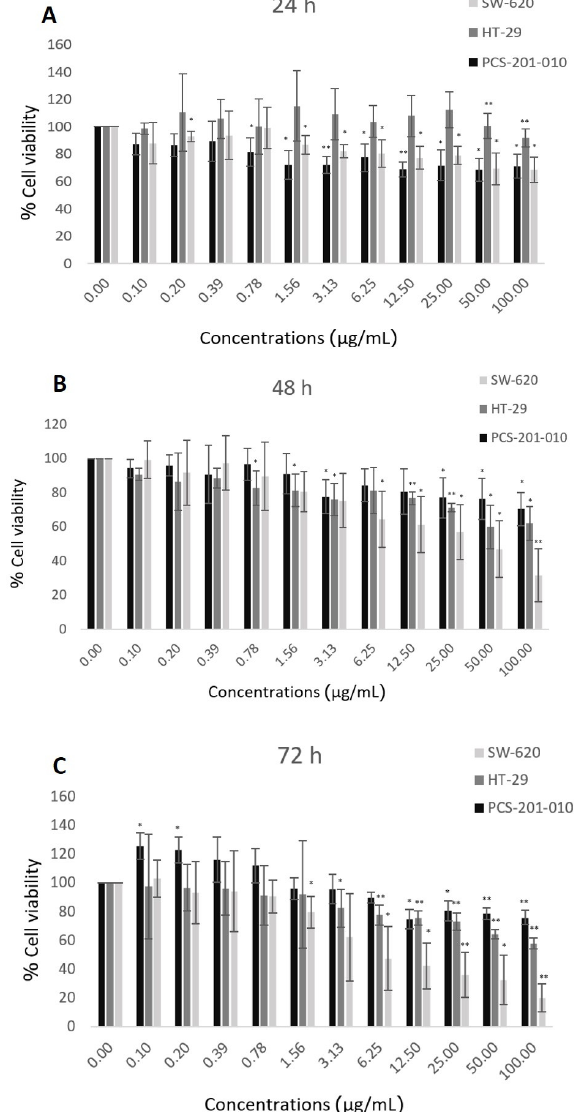
Figure 2. Cytotoxicity test by MTT assay on normal human fibroblast cell line (PCS-201-010), non- metastatic colon cancer cell line (HT-29) and metastatic colon cancer cell line (SW-620) after being treated with mitomycin C (as the positive control) concentrations (0–100 µg/mL) for 24 h ( A ), 48 h ( B ) and 72 h ( C ). The percentage of cell viability was determined as compared to an untreated condition. Data are represented by the mean ± SD. Statistical analysis was performed using one-way ANOVA (*, p ≤ 0.05 significant; **, p ≤ 0.01 significant).